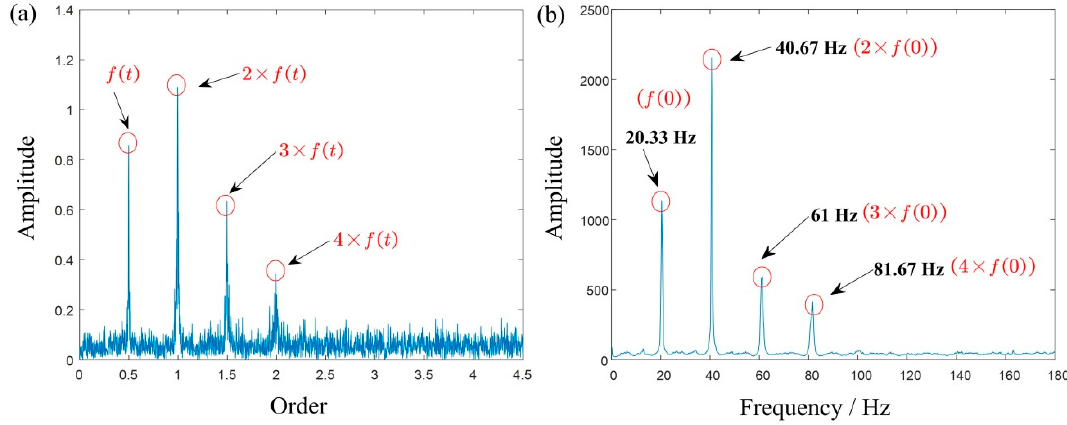
Figure 5. The result analysis of a multicomponent simulated signal: ( a ) order spectrum and ( b ) 2D energy-frequency map.